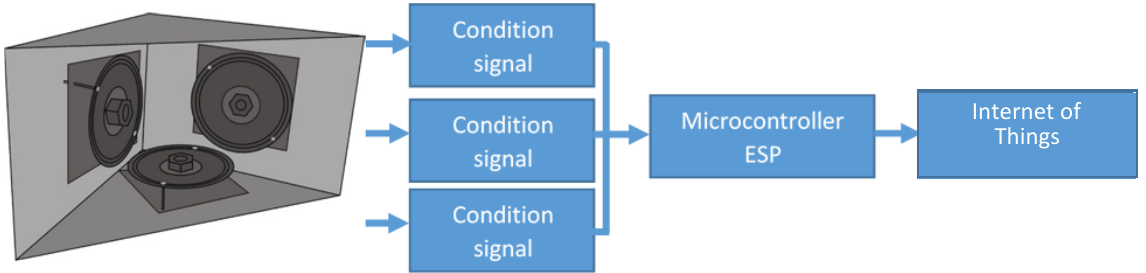
Figure 7. Cold lava material vibration